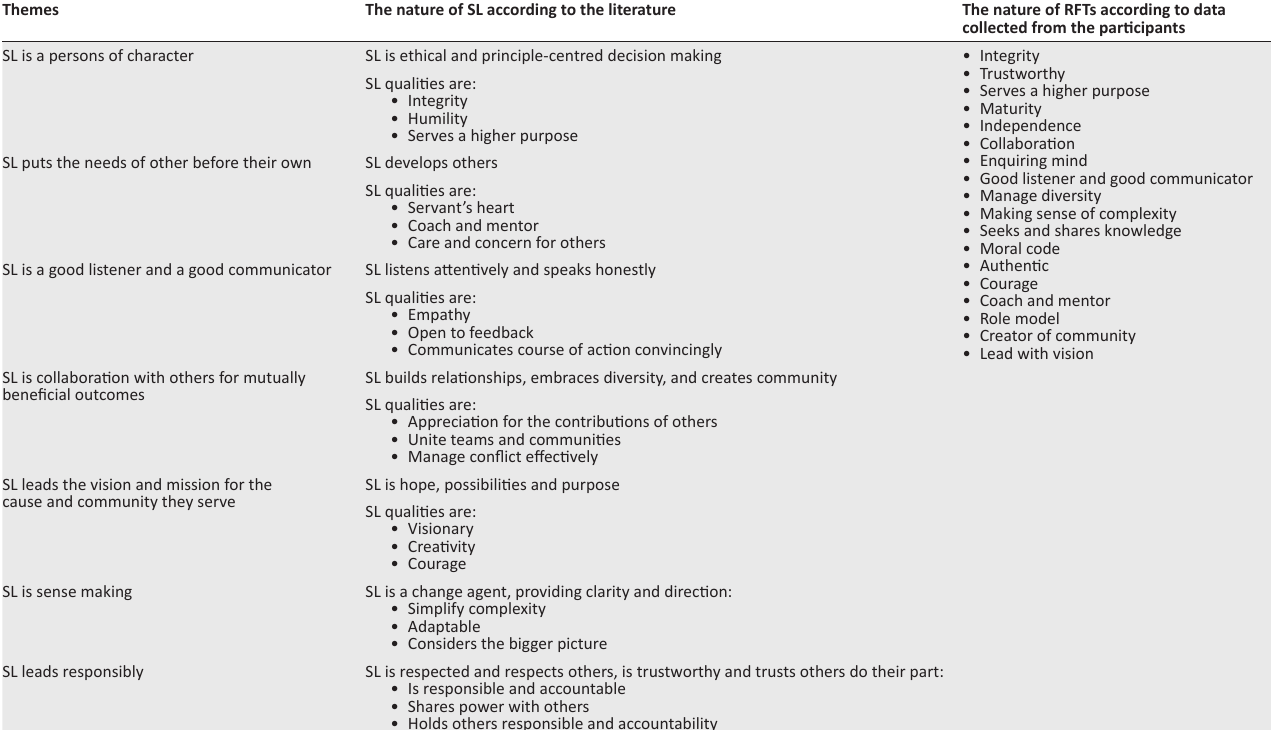
TABLE 3: Comparison between literature and data gathered.